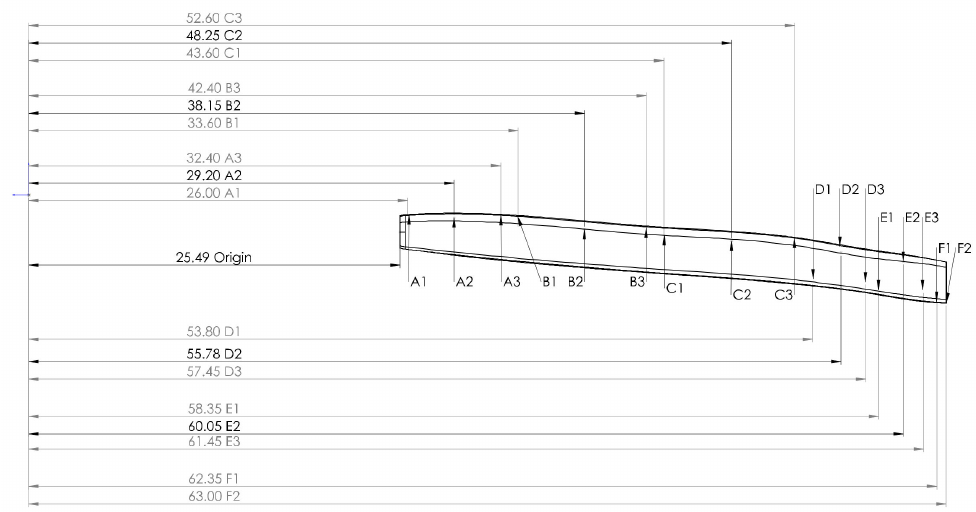
Figure 12. Lateral view of the passenger cabin with indication of the heat load measurement points identified per each